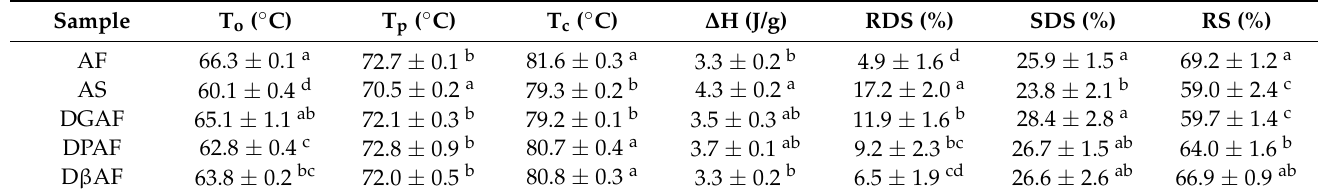
Table 3. Thermal and digestive properties of AF and after removal of non-starch nutrients.